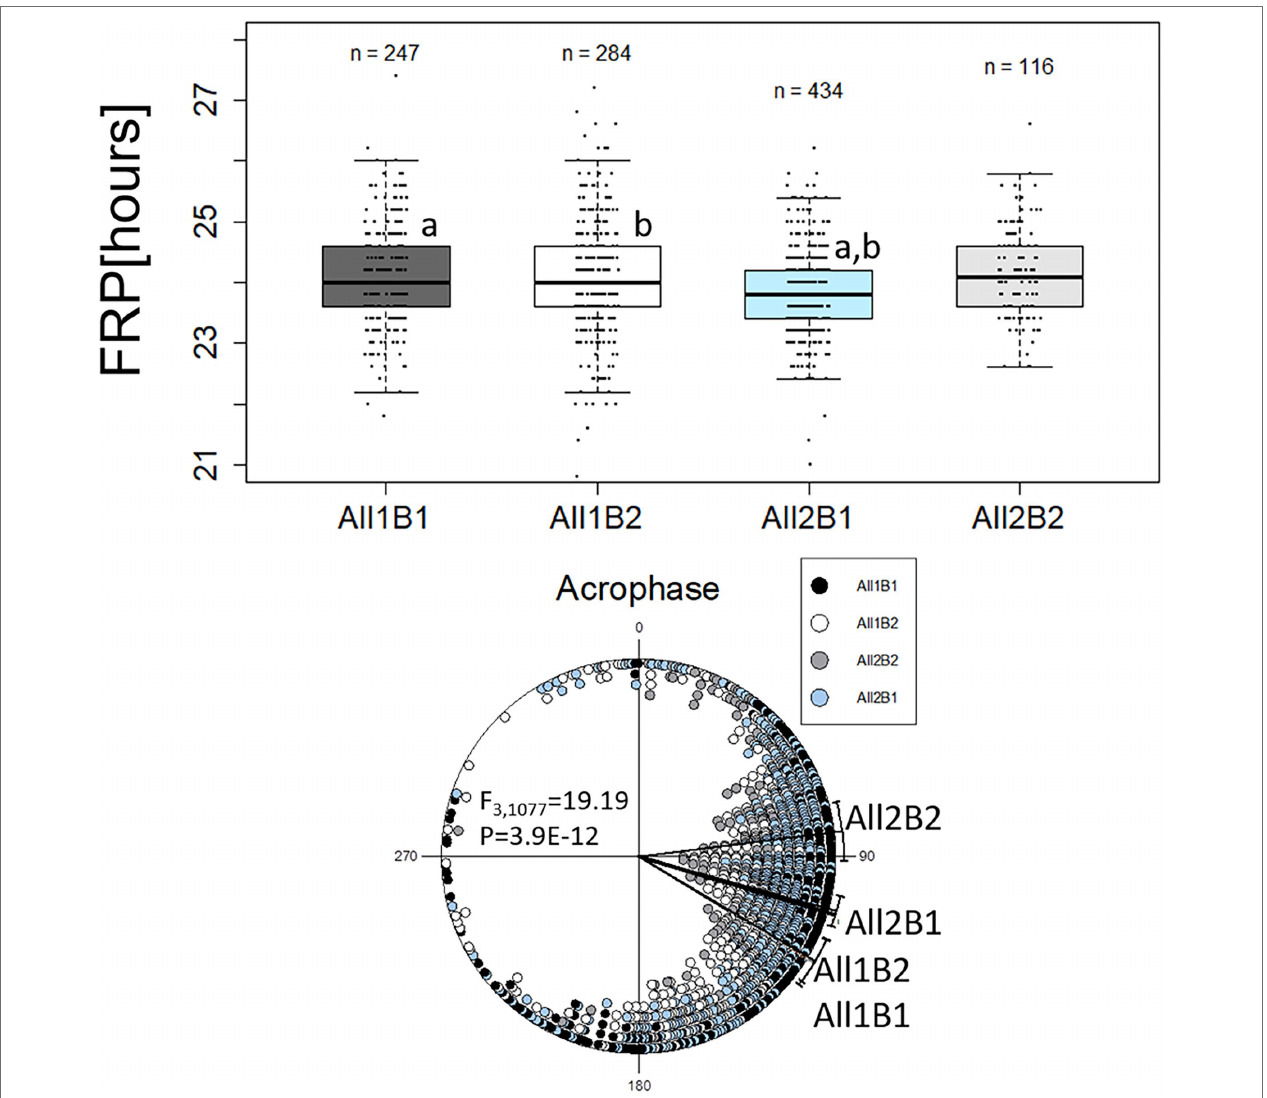
FIGURE 5 | Circadian free-running period (FRP) and acrophase of cry haplotypes. The FRP ( upper panel ) is depicted using a boxplot, where the middle line represents the median, and the box indicated the interquartile range (IQR). Whiskers signify 1.5 × IQR. White circles are potential outliers. Similar letters on boxplots indicate significant differences revealed by post-hoc tests (a, b, c, p < 0.05). FRP: All1B1 24 h ± 0.07 h (median ± SEM), All1B2 24 h ± 0.1 h, All2B1 23.8 h ± 0.03 h and All2B2 24.1 h ± 0.07 h. The circadian acrophase (phase in DD; lower panel ) was calculated over 5 days and is depicted by circular plots. Each symbol represents a single observation. 0 ° and 180 ° correspond to subjective light on (CT0) and light off (CT12), respectively (15 ° = 1 h). Acrophases: All1B1 121.16 ° ± 57.56 ° (mean vector ± circular standard deviation, n = 247); All1B2 120.61 ° ± 56.17 ° ( n = 284); All2B1 105.46 ° ± 46.50 ° ( n = 434); and All2B2 82.91 ° ± 46.21 ° ( n =